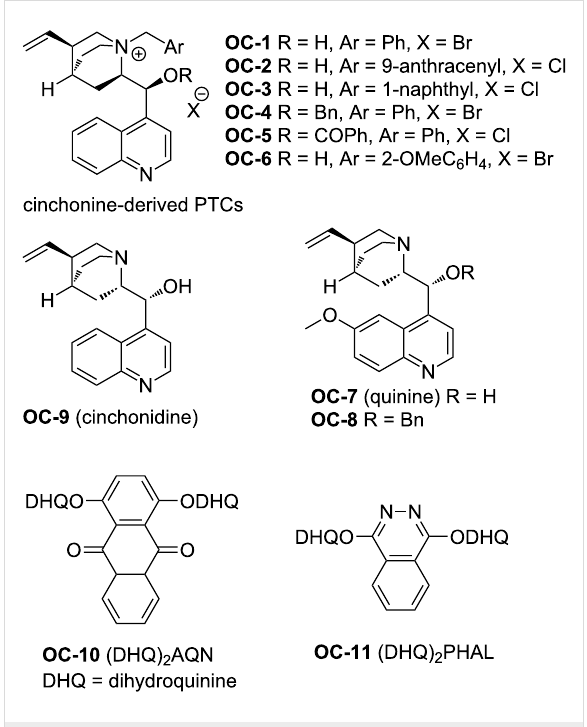
Figure 2: Cinchona alkaloid-derived catalysts OC-1 to OC-11 .